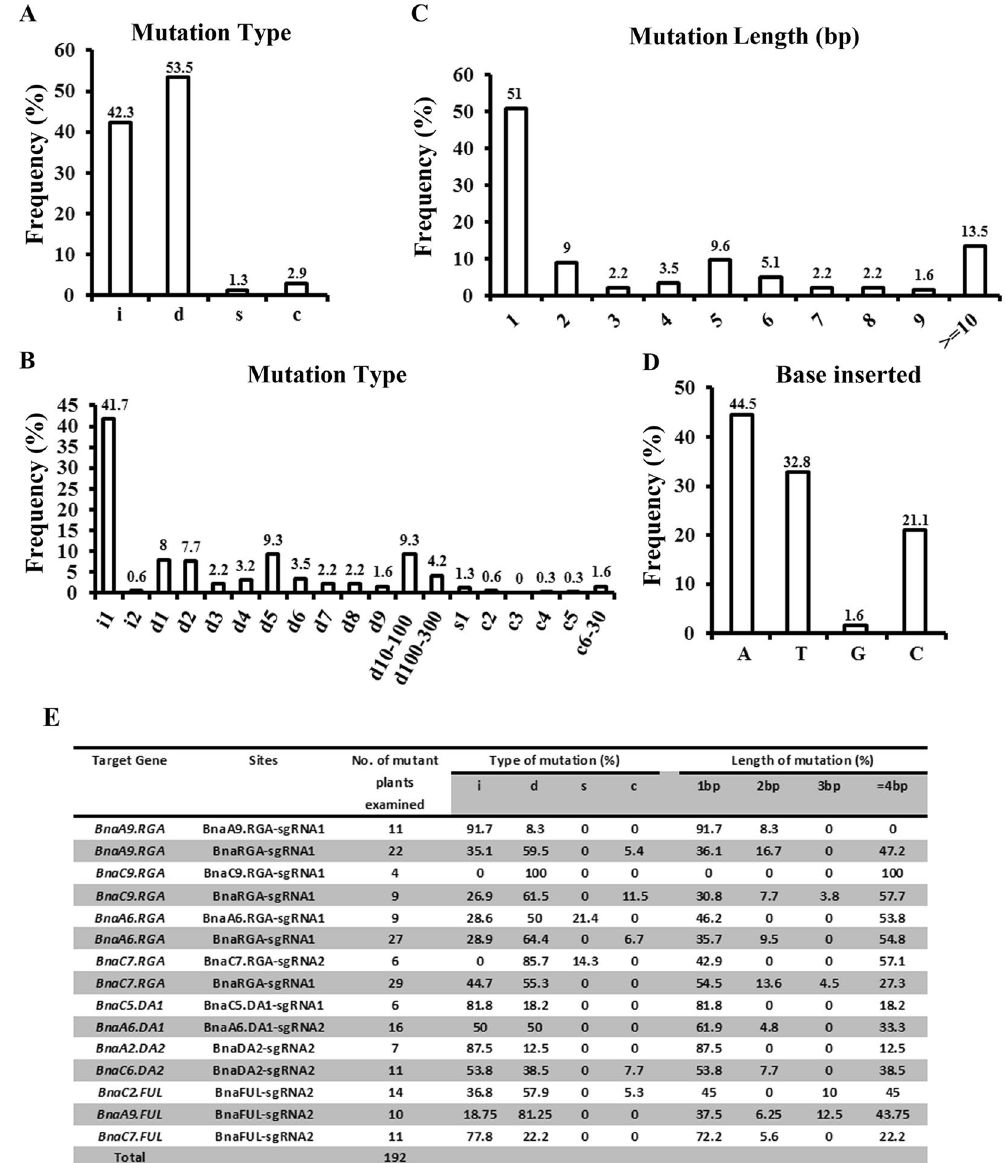
Figure 1. Frequency of CRISPR/Cas9-induced mutation types. ( A , B ) Frequency of each mutation type for all of the mutations induced by the 10 constructs in the T0 generation. i: insertion; d: deletion; s: substitution; c: combined mutation. d#, number of base pairs (bp) deleted from the target site; i#, number of bp inserted at target site, c#, number of bp combined mutations. ( C ) Frequency of different mutation lengths regardless of the mutation types using the data from ( A ). ( D ) Percentage of different bases for the 1-bp insertion (i1 in ( B )). ( E ) Detailed characterization of the different mutation types. Notes: i: insertion, d: deletion, s: substitution, c: combined mutation (more than one mutation type in one